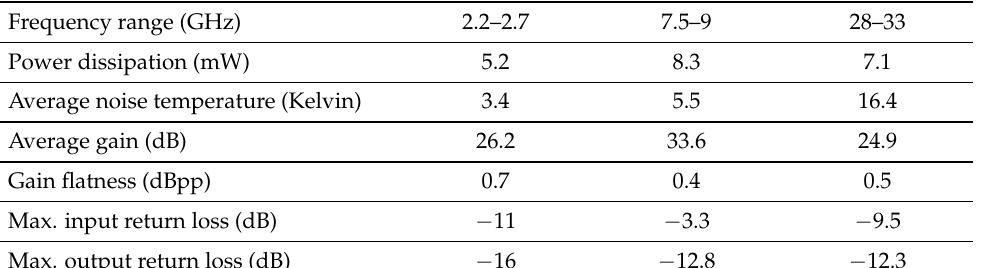
Table 3. Typical performance of tri-band receiver low noise amplifiers (LNAs).